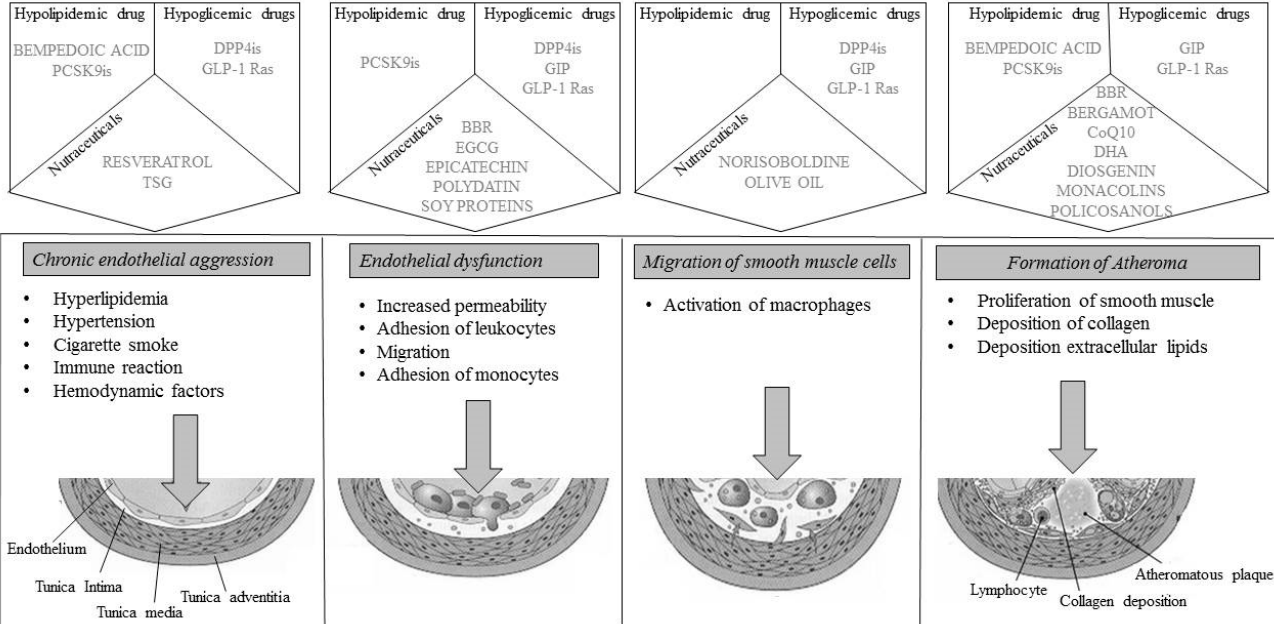
Figure 1. Representation of plaque progression with drug molecular actions. BBR: BerBeRine; CoQ10: Coenzyme Q110; DHA: DocosaHexaenoic Acid; DPP4is: DiPeptidyl Peptidase 4 inhibitors; EGCG: EpiGalloCatechin-3-Gallate; GIP: Glucose-dependent Insulinotropic Polypeptide; GLP-1 Ras; Glucagon Like Peptide-1 Receptor agonists; PCSK9is: Proprotein Convertase Subtilisin/Kexin 9 inhibitors; TSG: 2,3,4,5 ′ -TetrahydroxyStilbene-2- O - β - D -Glucoside.